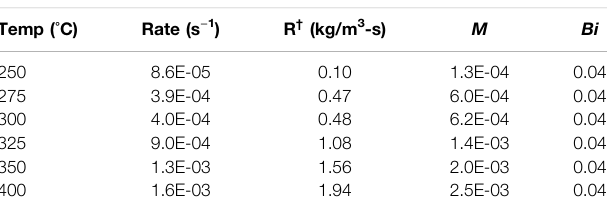
TABLE 2 | Bi and M at various